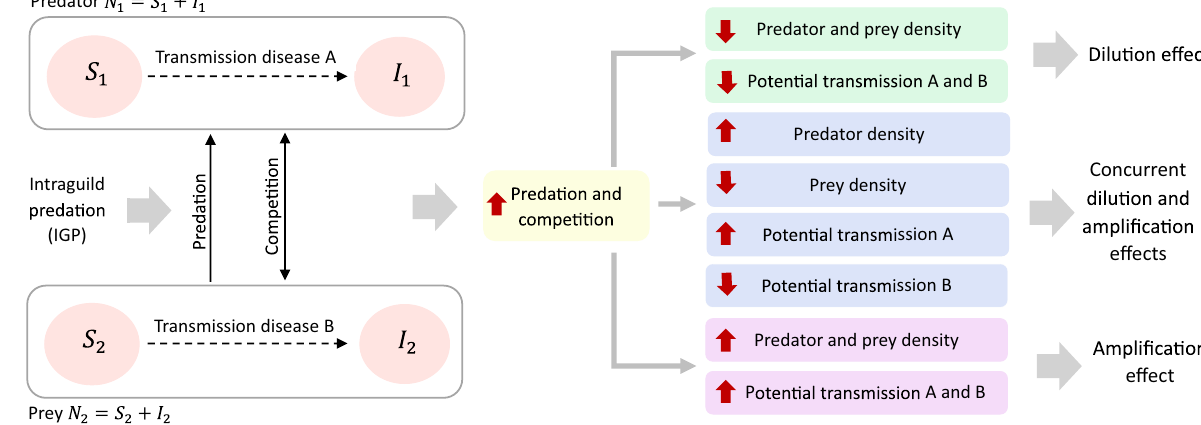
Figure 1. Schematic representation of an eco-epidemiological model and how competition and predation could affect the transmission and prevalence of a directly transmitted disease. Intraguild predation combines competition and predation between N 1 and N 2 species. Each species has a disease, the predators having disease A and the prey having disease B. The dotted arrow indicates disease transmission. The single-headed solid arrow indicates predation. The double-headed arrow represents interspecific competition. The direction of the arrowhead shows the flow of energy. Red upward arrows indicate an increase, and downward arrows indicate a decrease (adapted from Luis et al. 7 ).